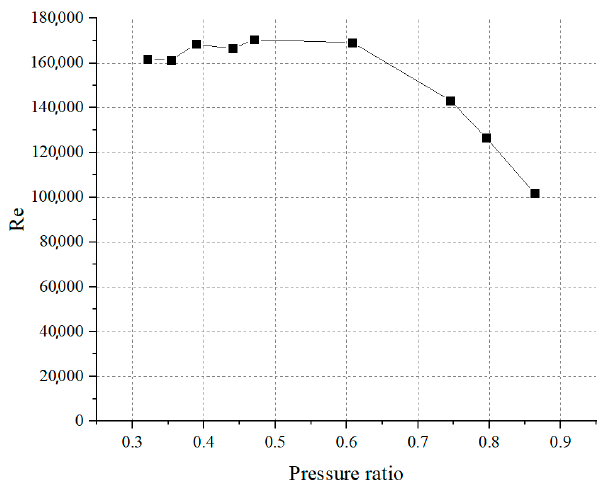
Figure 16. The local Re number at computation site n = 1.5 in Yuan’s experiment.